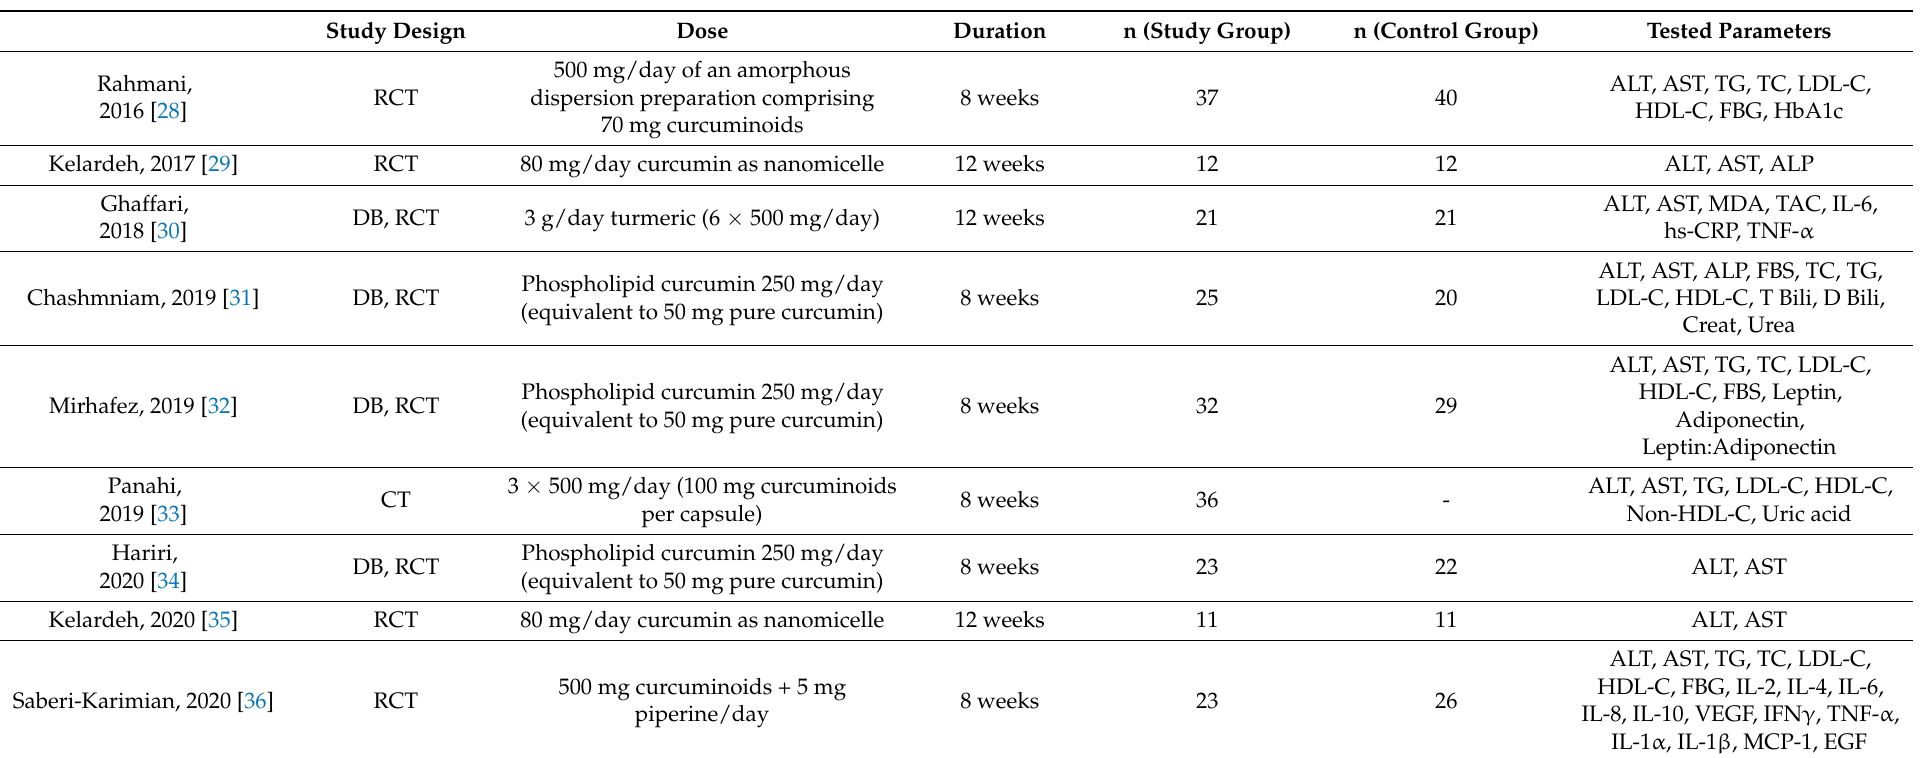
Table 3. Characteristics of included